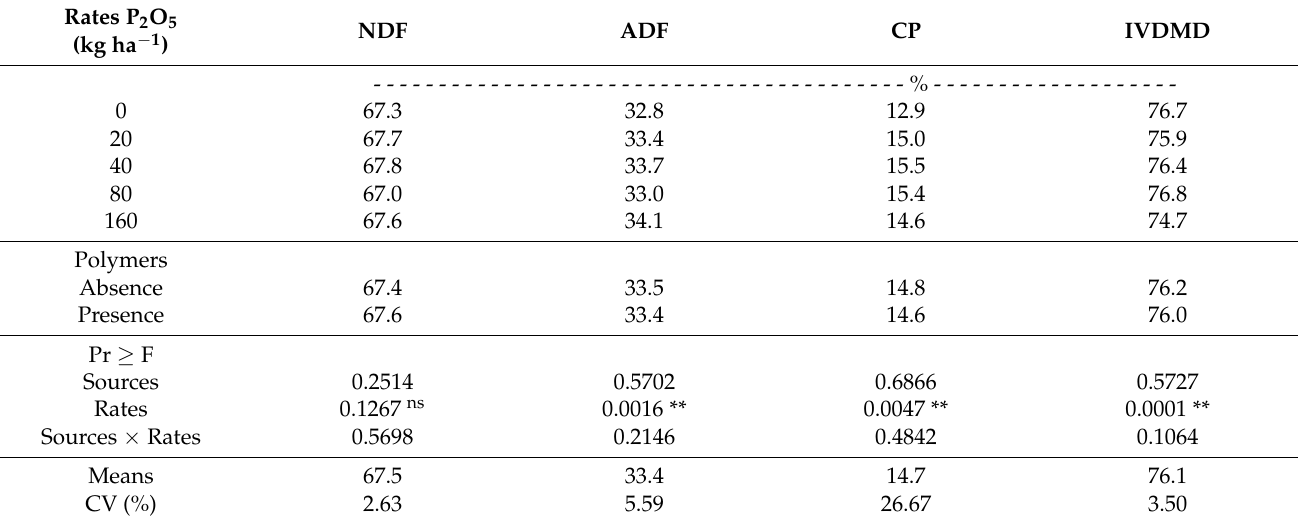
Table 4. Mean neutral detergent insoluble fiber (NDF), acid detergent insoluble fiber (ADF), crude protein (CP) content and in vitro true digestibility of dry matter (IVDMD) of Mavuno grass at different phosphorus sources and rates in the presence and absence of polymers in dystrophic Ultisol, Araçatuba, SP,